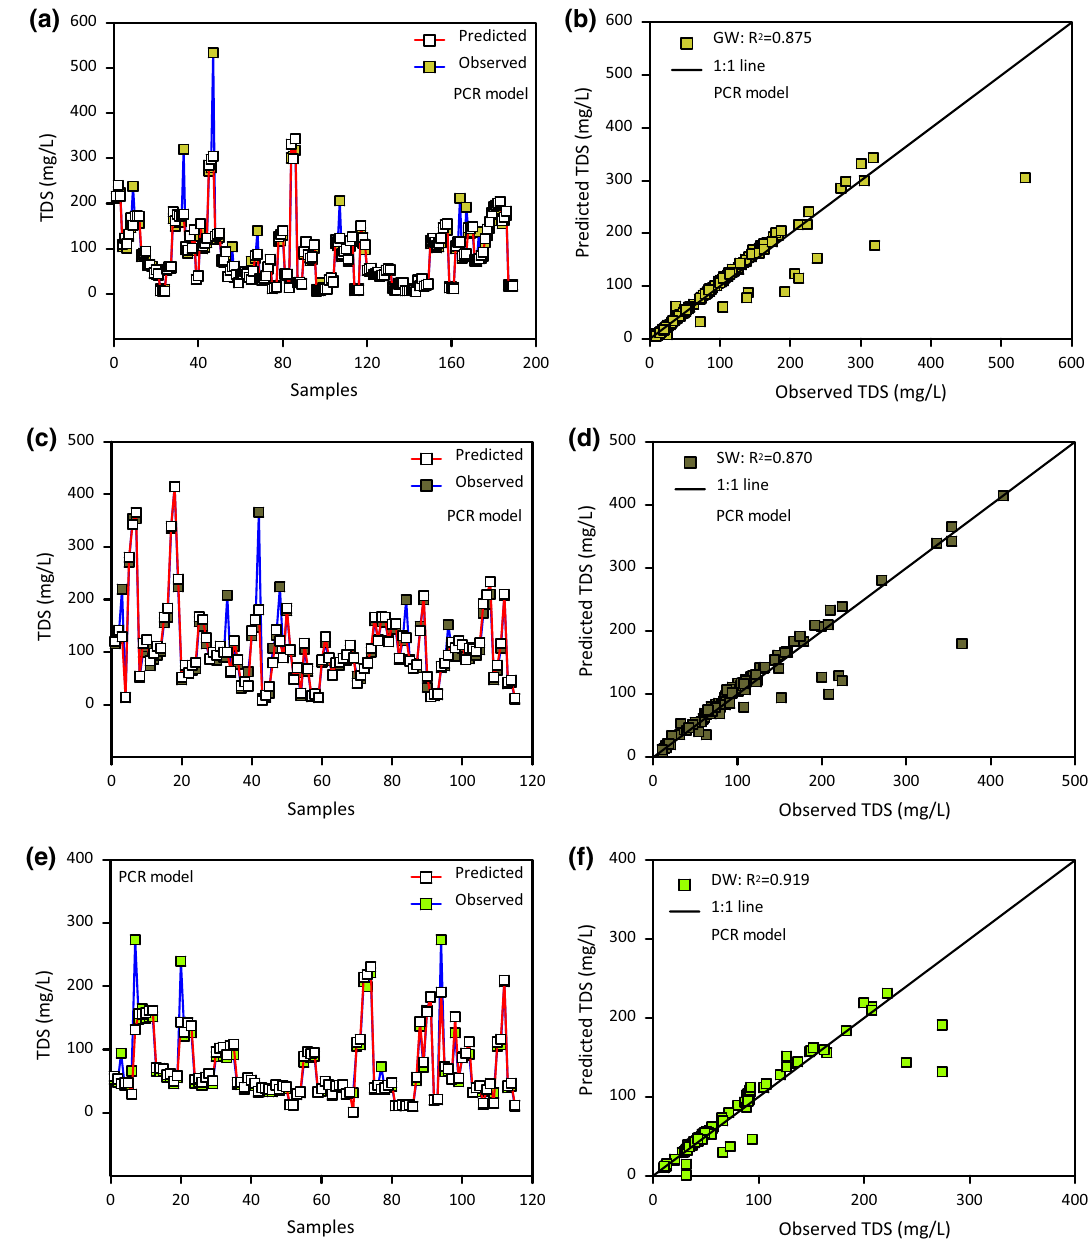
Fig. 8 Performance of PCR model: a predicted TDS for each sam- pling points in GW; b predicted vs observed TDS in GW; c predicted TDS for each sampling points in SW; d predicted vs observed TDS in